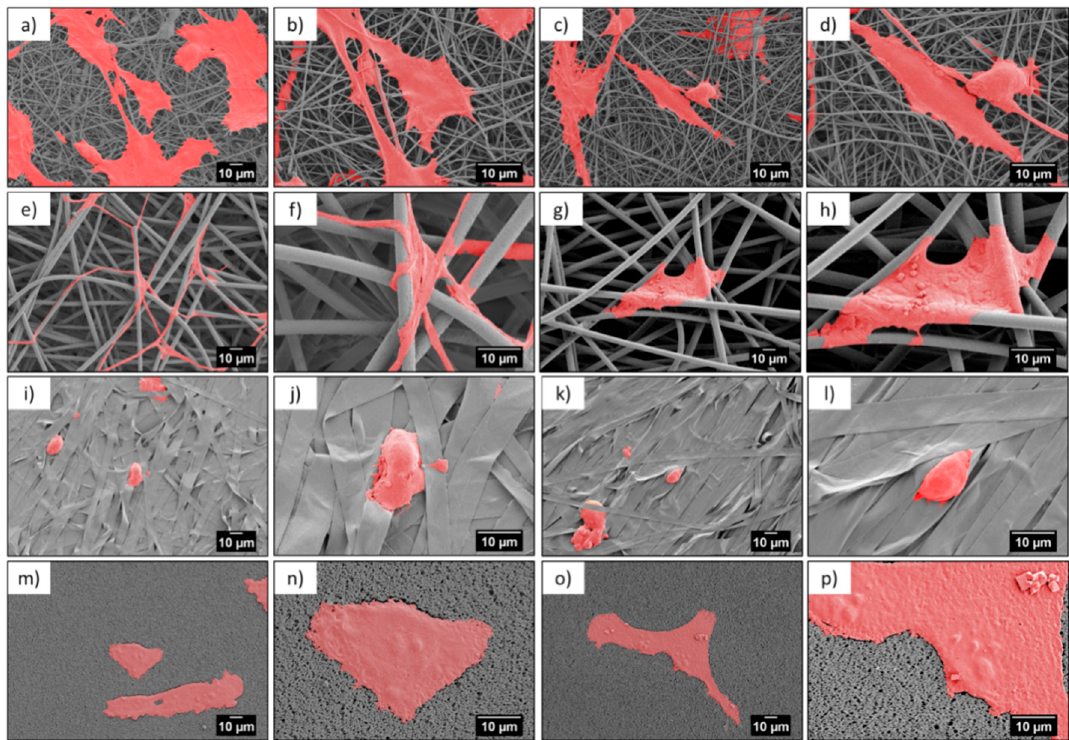
Figure 4. SEM micrographs of cells (colored in red) after 1 day in cell culture on PMMA scaffolds built of ( a – d ) nanofibers, ( e – h ) microfibers, ( i – l ) ribbons, and ( m – p ) film.